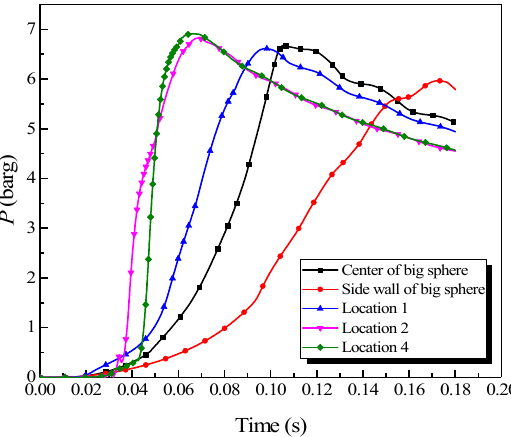
Figure 8. Natural gas explosion pressure versus time by changing the ignition positions.